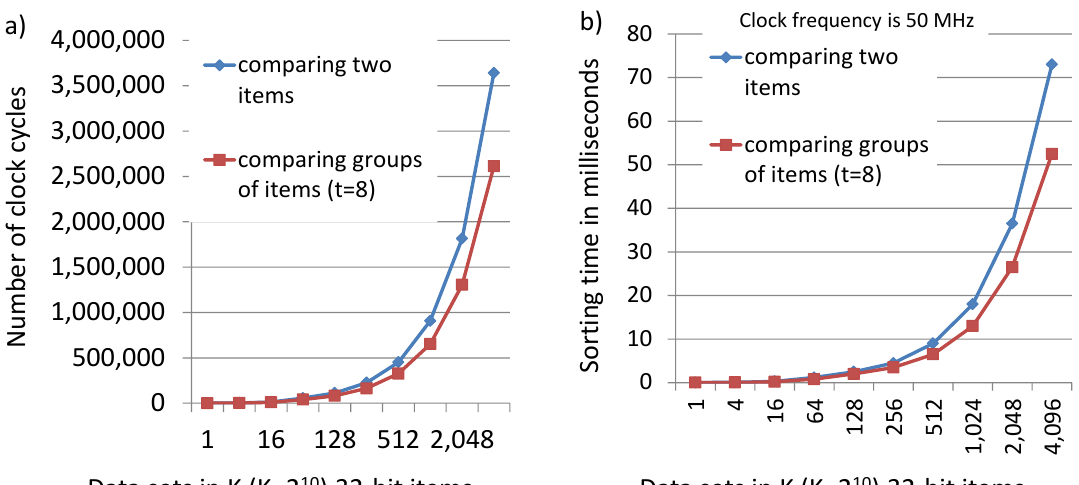
Fig. 11. The results of simulation in software of circuits for complete data sorters.